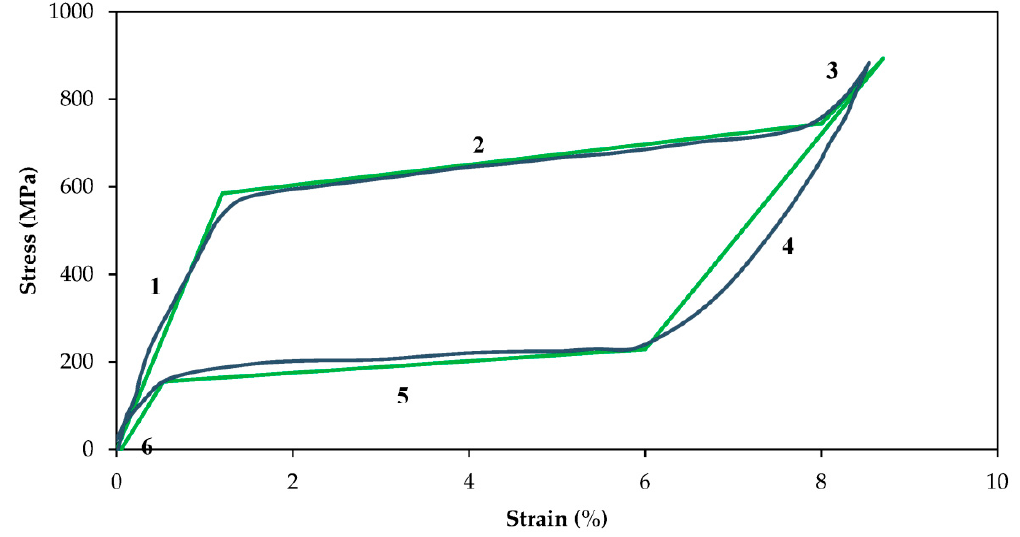
Figure 8. Stress-strain plots of superelastic NiTi wires and the validation of the UMAT.